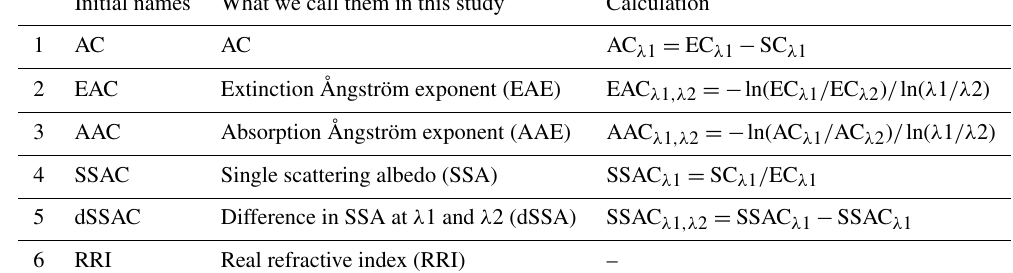
Table 2. In situ optical parameters used in this study (provided at a given aircraft altitude by the instruments in lines 6–8 of Table 1), the way we call them in this paper, and how they are computed. The way we call these parameters is closer to what would be observed from remote sensing instruments. In the calculations, λ 1 and λ 2 are two given wavelengths. In this paper, we compute (i) SSA and AC at 450, 550 and 700nm; (ii) EAE, AAE and dSSA between 450–550, 550–700 and 450–700nm; and (iii) RRI at 532nm.